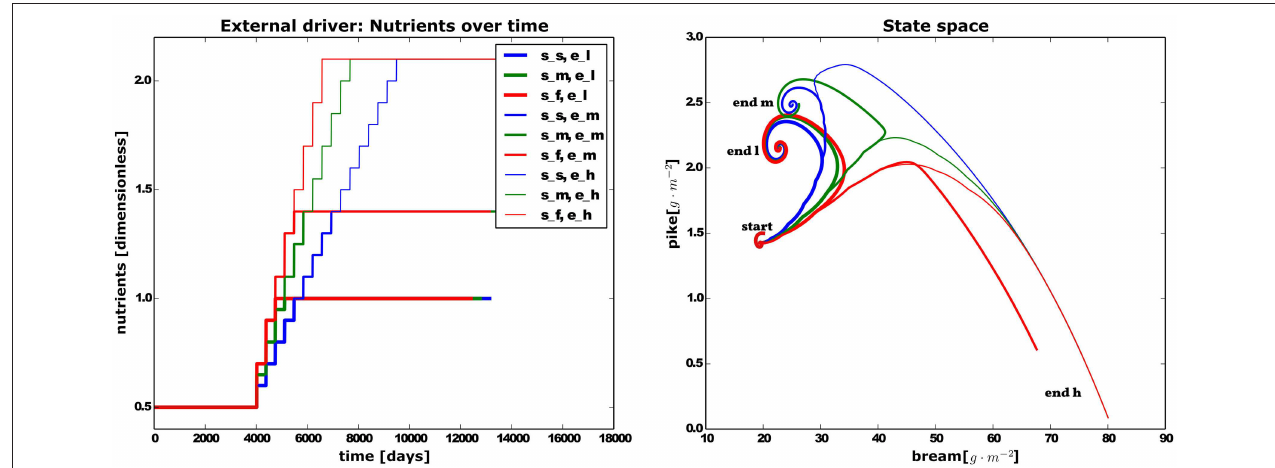
FIGURE 5 | Left: Nutrient time series as driver for scenarios, at three rates (speed: slow, medium, high), and three different destination levels (end: low, medium, high), showing results from nine simulations in total. Right: The resulting fish populations in the state space. At the lowest nutrient levels, the resulting fish state is independent of the rate of change. But in the intermediate nutrient level, fish populations driven by the fastest increase (red) experience pike reduction while at slower rates pike increases can be observed. At the highest nutrient level, all fish simulations result in the